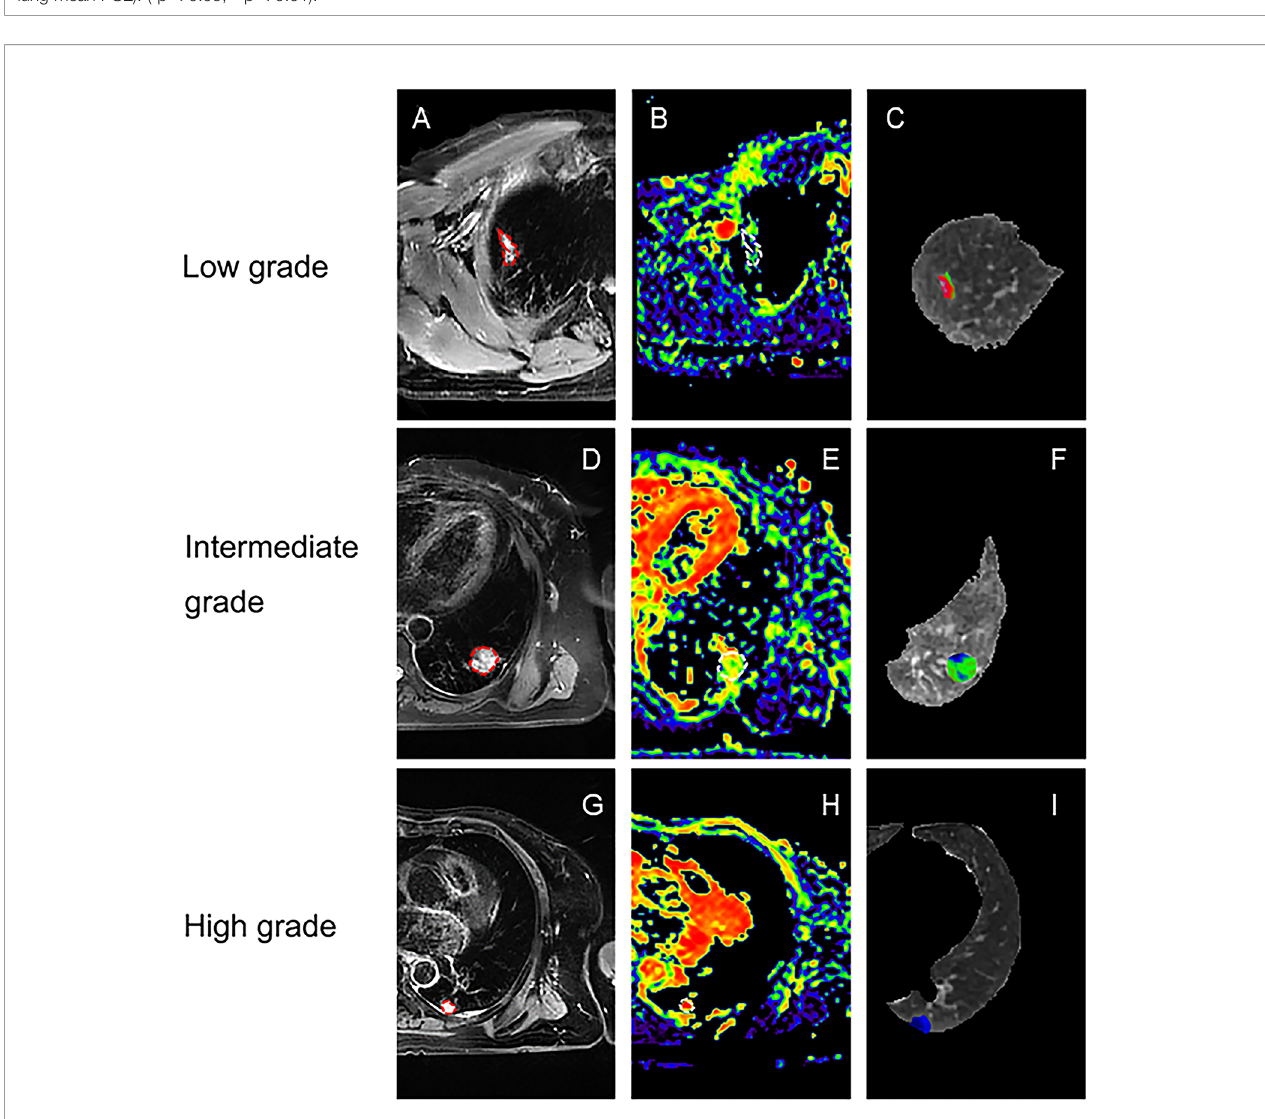
FIGURE 2 | Representative lesion-based analysis of LUAD patients. (A) Transverse T2 image for patient with low histological tumor grade (lepidic predominant adenocarcinoma); (B, C) are corresponding f map and PSE map for (A) ; (D) Transverse T2 image for patient with intermediate histological tumor grade (acinar predominant adenocarcinoma); (E, F) are corresponding f map and PSE map for (D) ; (G) Transverse T2 image for patient with high histological tumor grade (solid predominant adenocarcinoma); (H, I) are corresponding f map and PSE map for (G) ;.